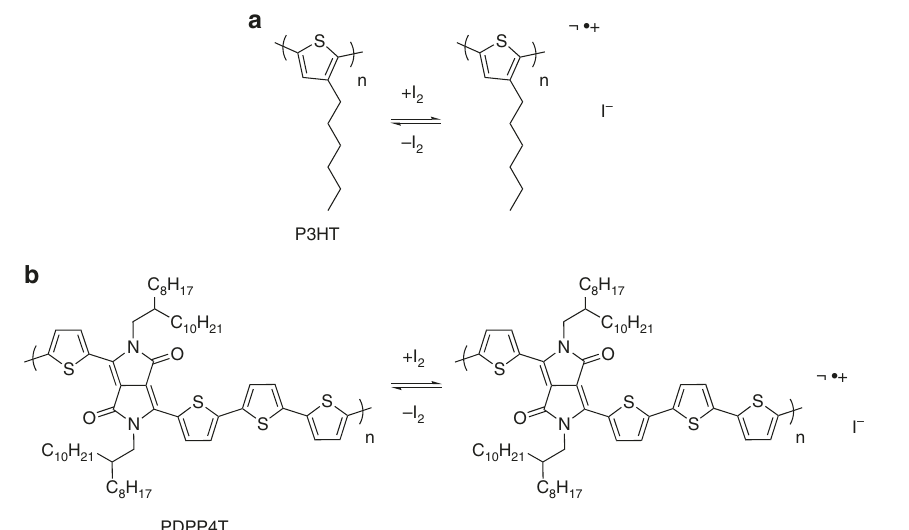
Fig. 1 Schematic of doping and de-doping of conjugated polymers using iodine. a poly(3-hexylthiophene) P3HT and b poly[2,5-bis(2-octyldodecyl)pyrrolo [3,4-c]pyrrole-1,4(2H,5H)-dione-3,6-diyl)-alt-(2,2 ′ ;5 ′ ,2 ′′ ;5 ′′ ,2 ′′′ -quaterthiophen-5,5 ′′′ -diyl)] (PDPP4T) are chemically doped in the presence of iodine vapor, but are unstable and gradually de-dope in the absence of iodine